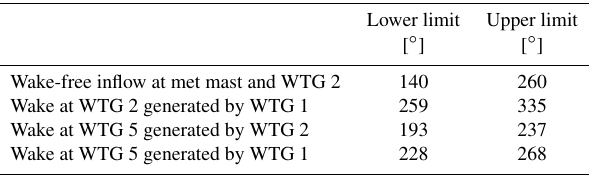
Table 1. Considered wind direction sectors for wake-free inflow and analyzed wake